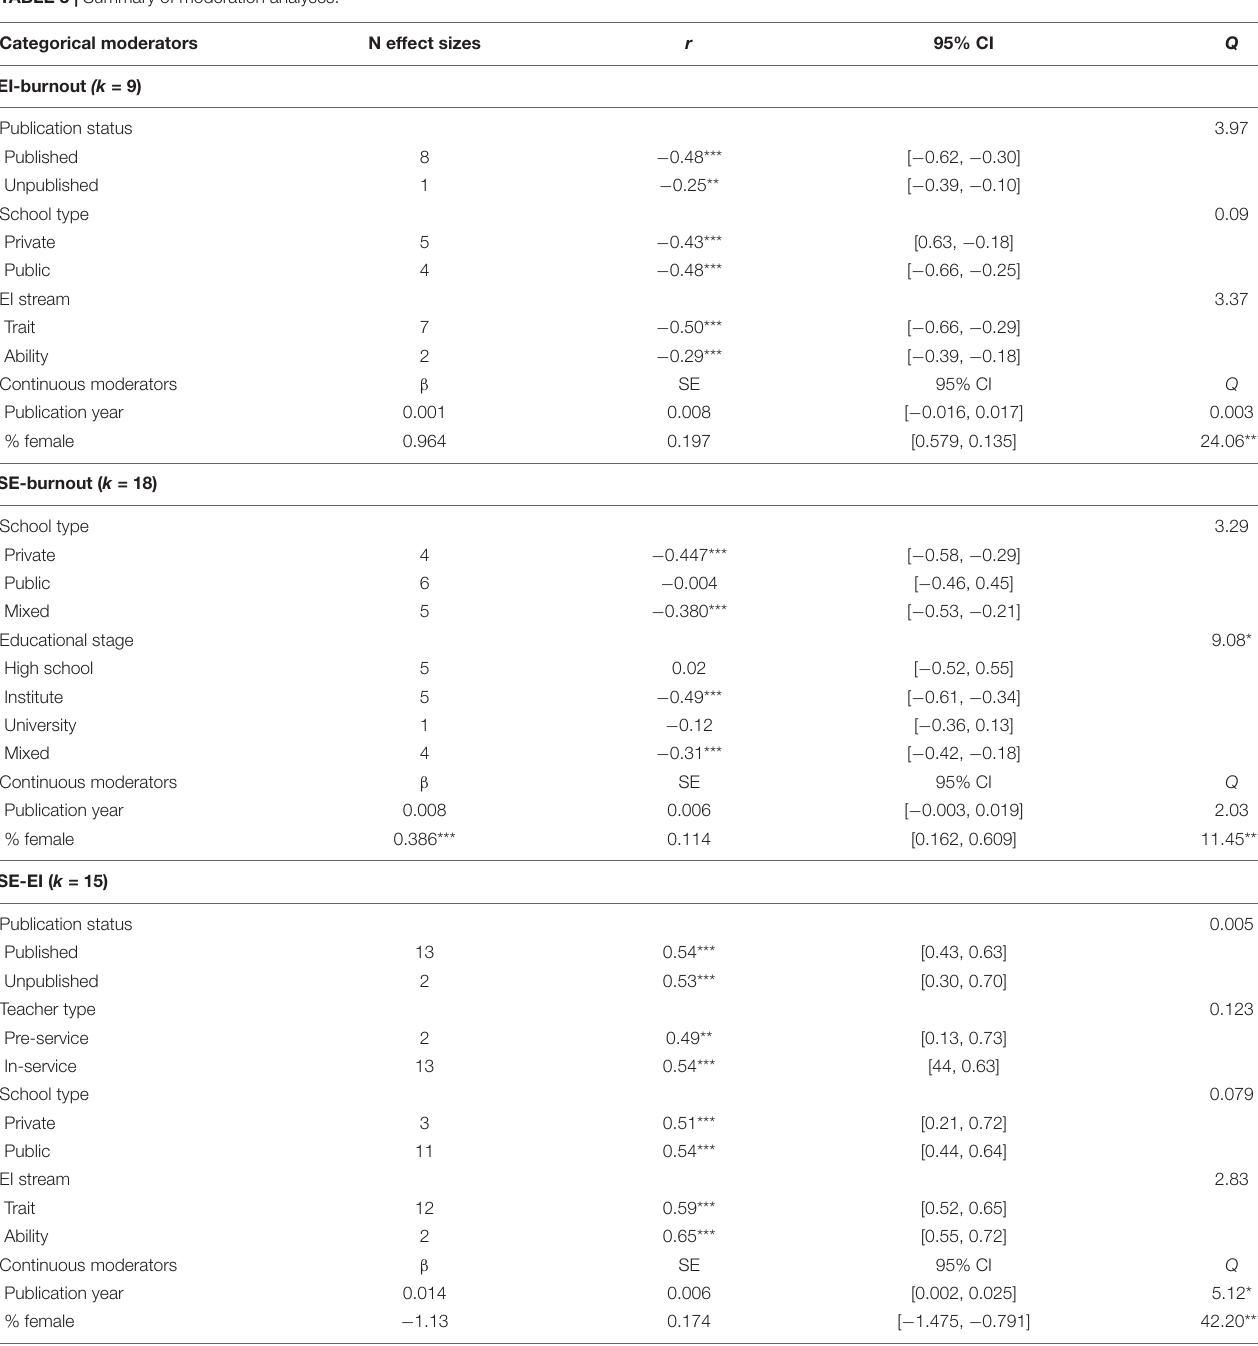
TABLE 3 | Summary of moderation